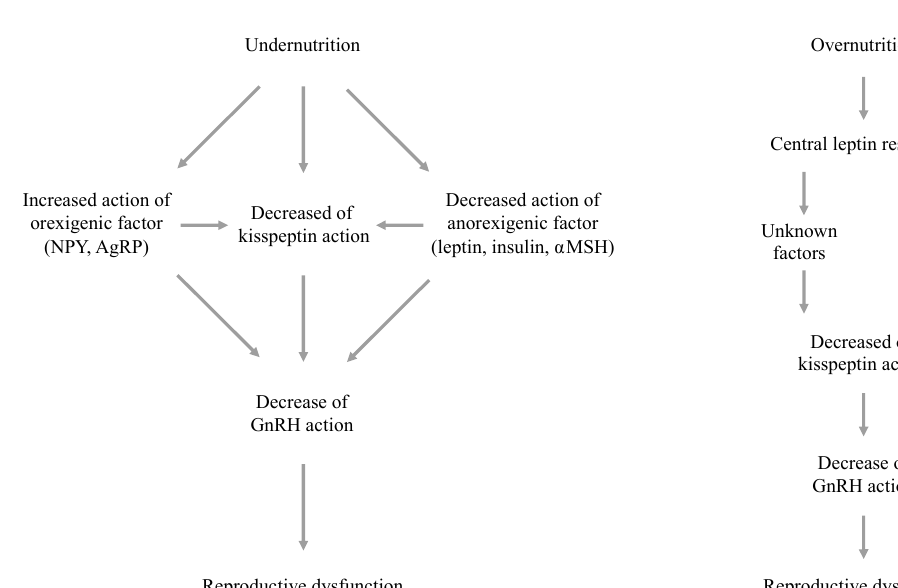
Figure 1. The roles of central and peripheral factors in reproductive dysfunction under under- nourished and over-nourished conditions. In addition to their primary functions, appetite- and metabolism-regulating factors; i.e., orexigenic and anorexigenic factors, suppress or activate GnRH secretion. Changes in the levels of these factors promote feeding behavior, whereas they coordinately suppress GnRH secretion and induce reproductive dysfunction in the presence of a negative energy balance. In addition, kisspeptin neurons are sensitive to metabolic status, and their activities are suppressed in the presence of a negative energy balance. Such changes also adversely affect GnRH secretion. It has been revealed that the effects of appetite- and metabolism-regulating factors on GnRH are partially mediated by kisspeptin neurons. In addition, overnutrition induces central leptin resistance and this alteration directly and indirectly decrease kisspeptin action on GnRH, and consequently induce reproductive dysfunction.